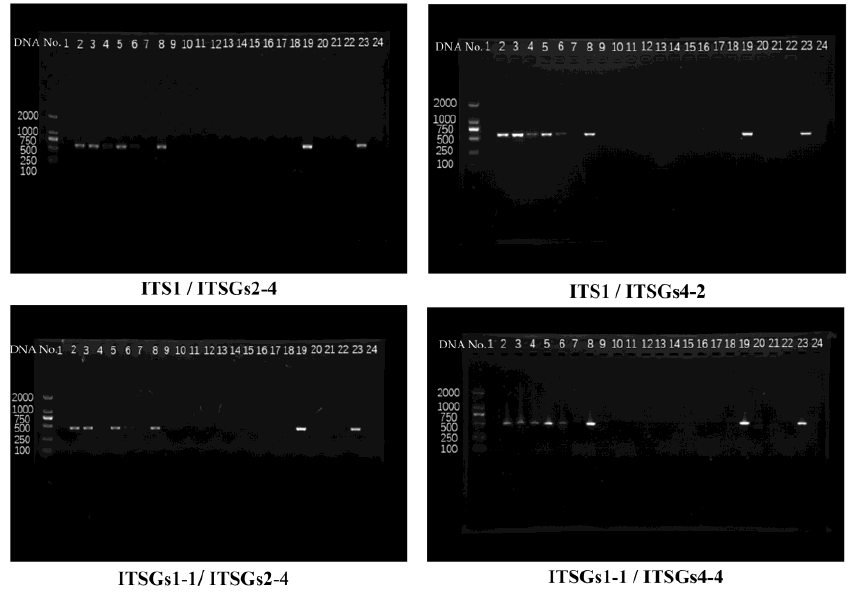
Figure 2. Gel electrophoresis image.